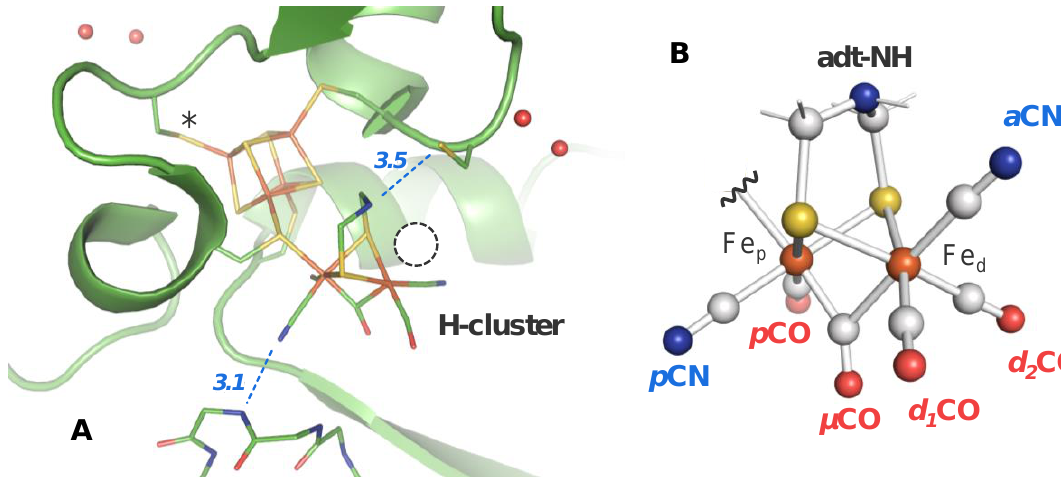
Figure 1. Crystal structure of the H-cluster in [FeFe]-hydrogenase. ( A ) The structure ( protein data bank entry 4XDC) [28] of the Clostridium pasteurianum enzyme (CPI) is poised in the oxidized resting state (Hox). The CN ‒ ligand at Fe p is stabilized by a hydrogen bond (blue dashes) to the protein backbone [29], whereas the diatomic ligands at Fe d are located in a hydrophobic pocket. The aminodithiolate (adt) group may be hydrogen-bonded to C299 (blue dashes). The asterisk marks a likely protonation site at the [4Fe – 4S] cluster. Catalytic protons are exchanged via adt-NH and C299 in the putative proton transfer pathway to the diiron site. The circle marks the open coordination site at Fe d where exogenous CO initially binds to form the CO-inhibited, oxidized state (Hox-CO). ( B ) Proposed structure of the H-cluster in the Hox-CO state (the [4Fe – 4S] cluster is omitted for clarity). The orientation of the diatomic ligands in various cofactor states is under debate.